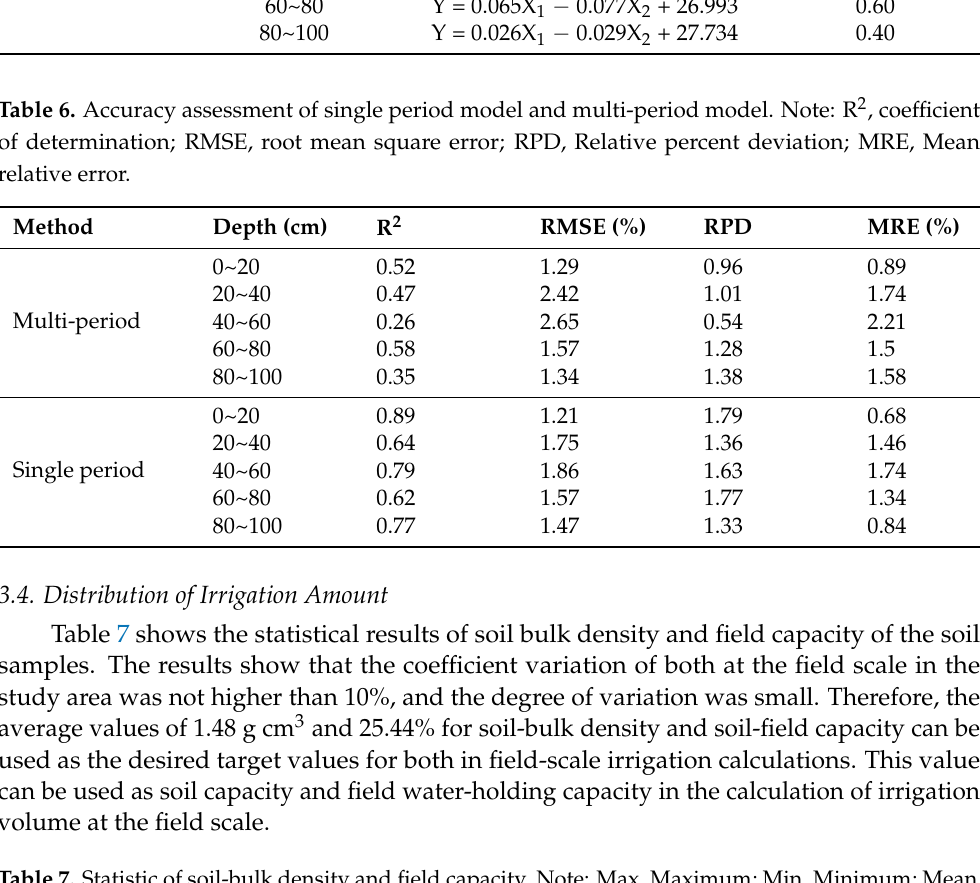
Table 7. Statistic of soil-bulk density and field capacity. Note: Max, Maximum; Min, Minimum; Mean, mean; CV, Coefficient of